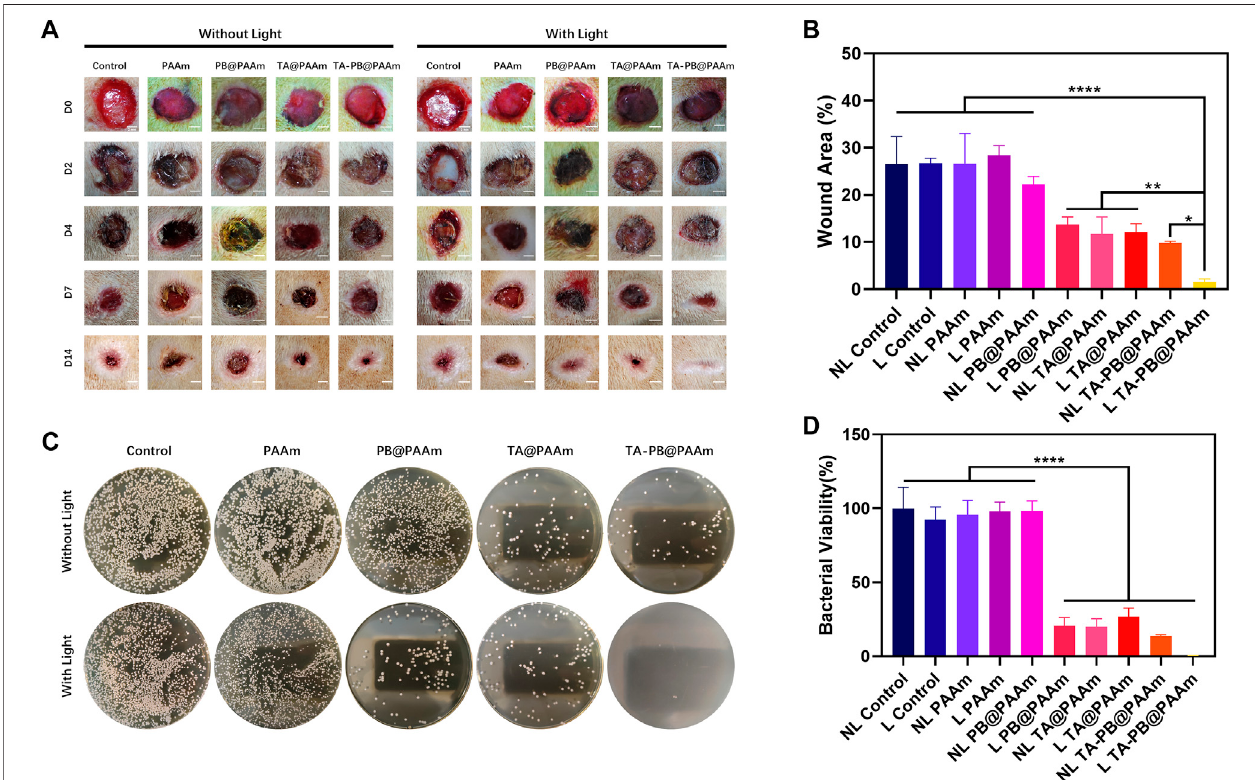
FIGURE 6 | Wound healing in SD rats. (A) Results of skin repair of infectious skin defect in animal model. Scale bar (cid:1) 2 mm. (B) Quantitative results of the areas of wound healing. (C) In-vivo bacteriostatic experiments using different hydrogels on Staphylococcus aureus . (D) Quantitative results of the areas with a survival rate of Staphylococcus aureus . Data are mean ± SD (n (cid:1) 3, * p < 0.05,** p < 0.01, **** p <